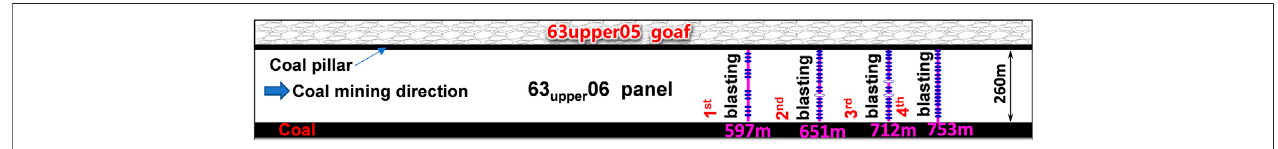
FIGURE 4 | Schematic diagram of deep-hole blasting position.